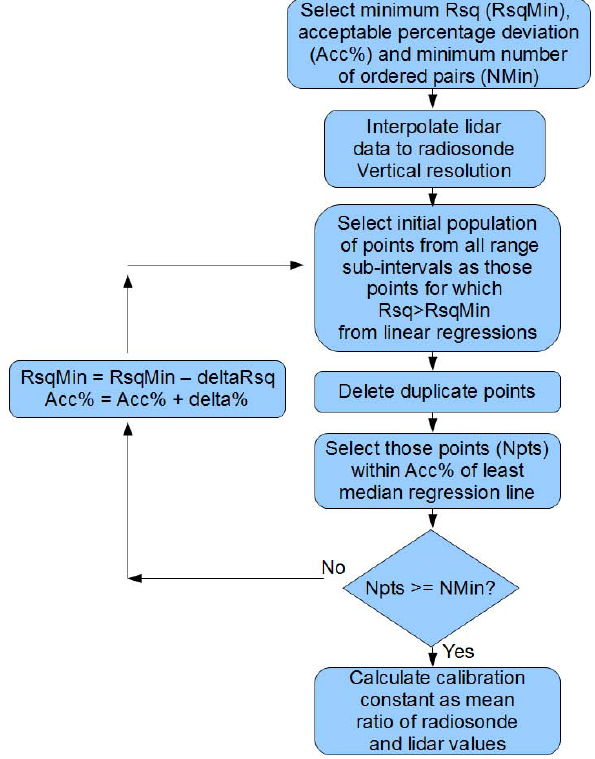
Fig. A5. Flow chart for the adaptive algorithm used to select geo- metrically similar portions of the lidar and radiosonde profiles for determining the lidar calibration constant. See text for more details. In the flow chart, ”Rsq” refers to R 2 and ”deltaRsq” to 1R 2 .